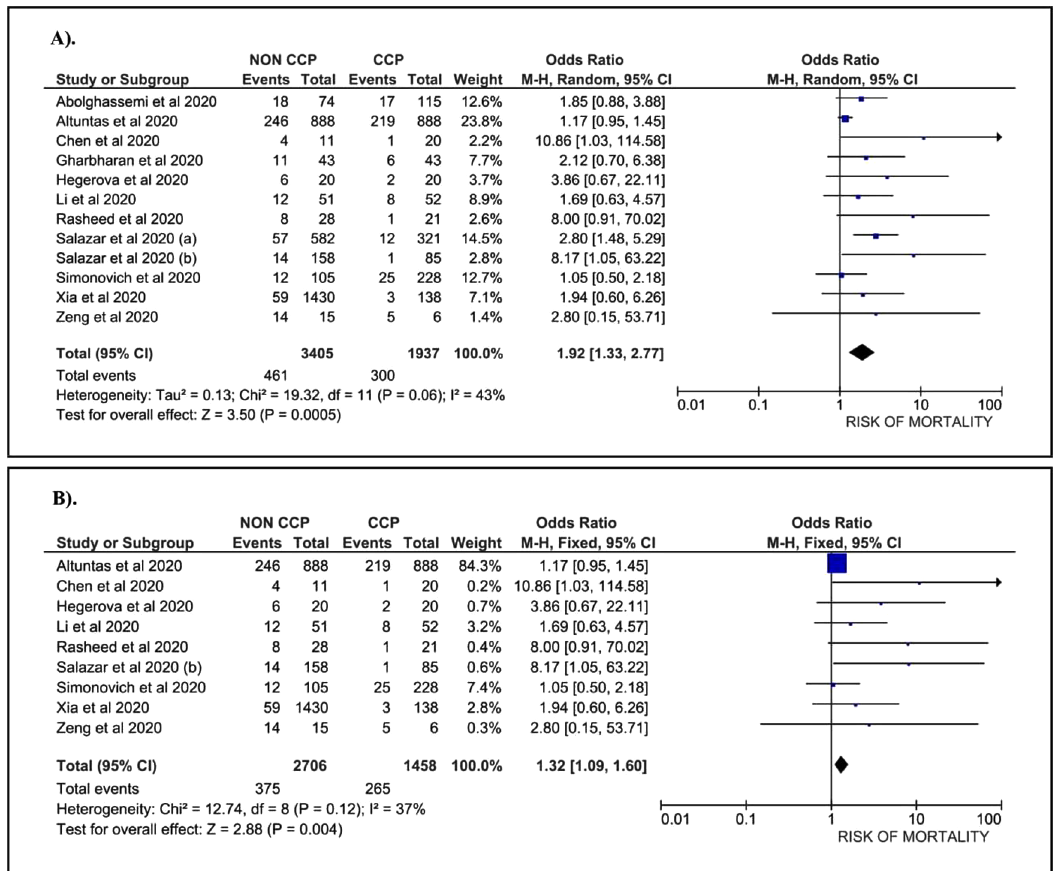
Figure2.Forestplotoftheassociationbetweenconvalescentplasmaandtheriskofmortality. A).Allcases(OR: 1.92; 95%CI: 1.33, 2.77; p = 0.0005; p Egger: 0.3620; p Heterogeneity: 0.0600; I-squared: 43.00%). B). Severe COVID-19 (OR: 1.32; 95%CI: 1.09, 1.60; p = 0.0040; p Egger: 0.3790; p Heterogeneity: 0.1200; I-squared: 37.00%).